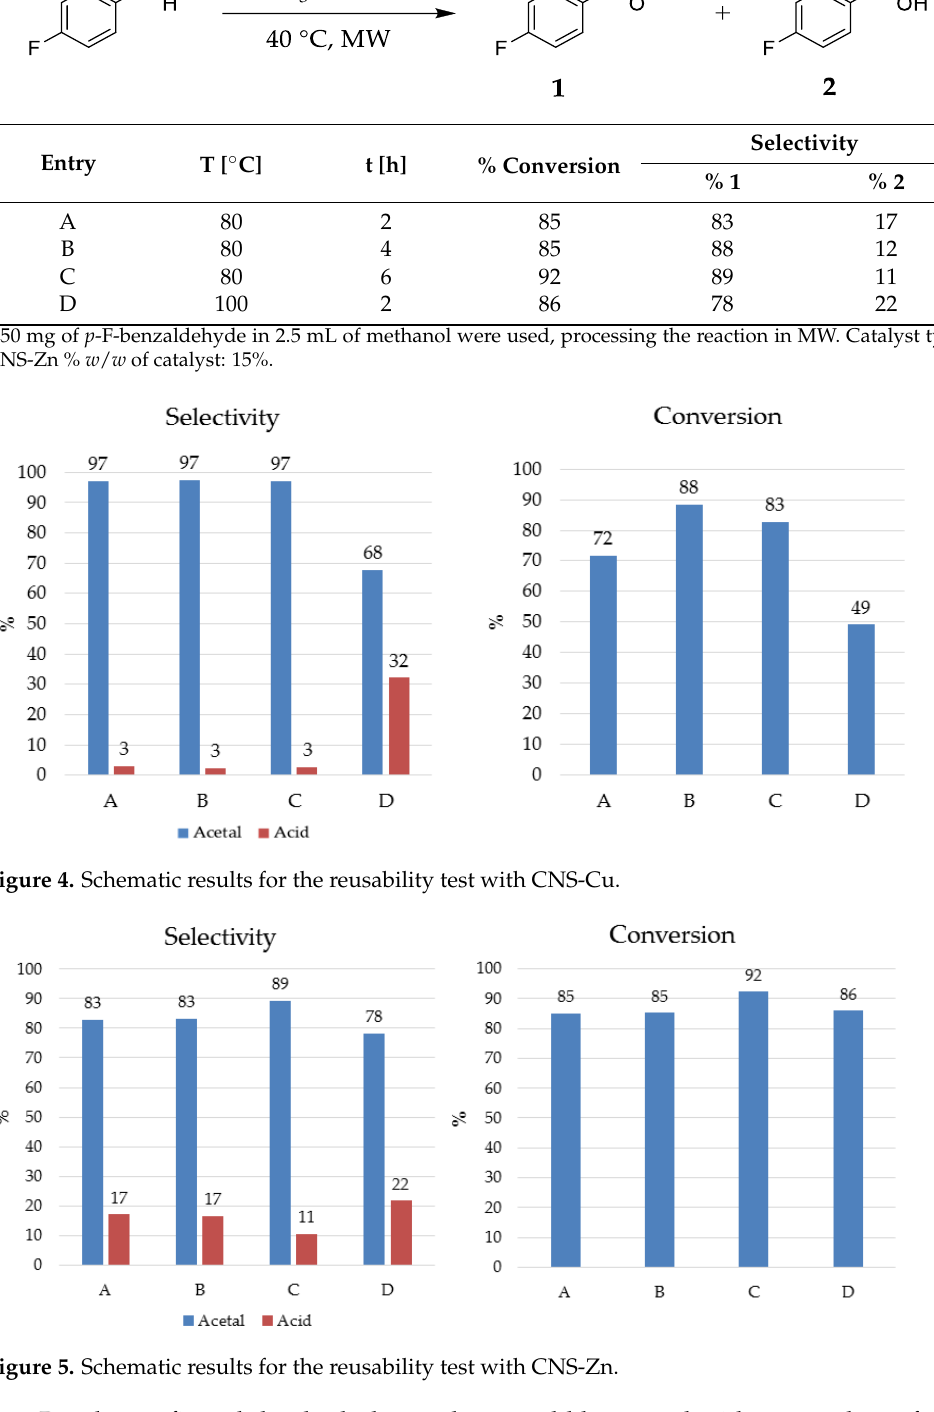
Figure 5. Schematic results for the reusability test with